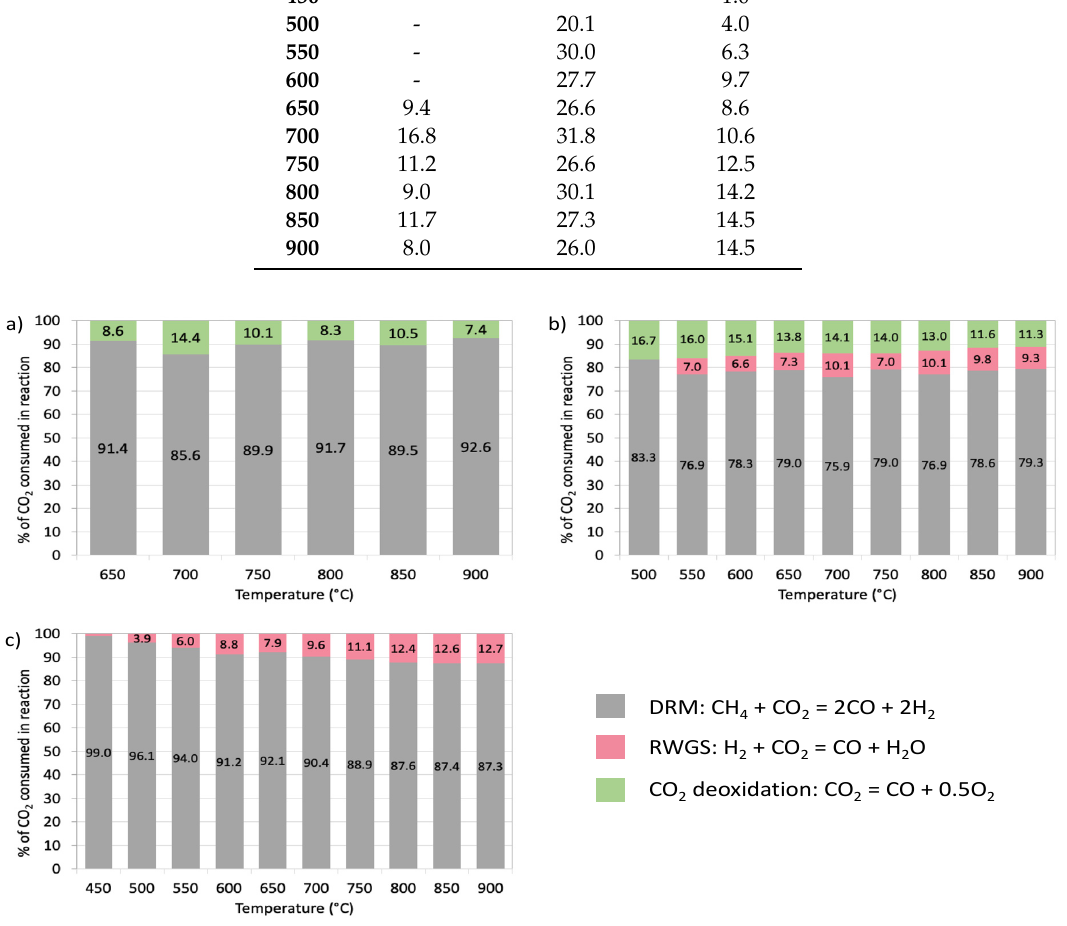
Figure 9. Contribution of CO 2 in DRM, reverse water gas shift reaction (RWGS) and CO 2 deoxidation reactions during DRM over CZ/CNT ( a ), NiCZ/CNT ( b ) and Ni/CNT ( c ).